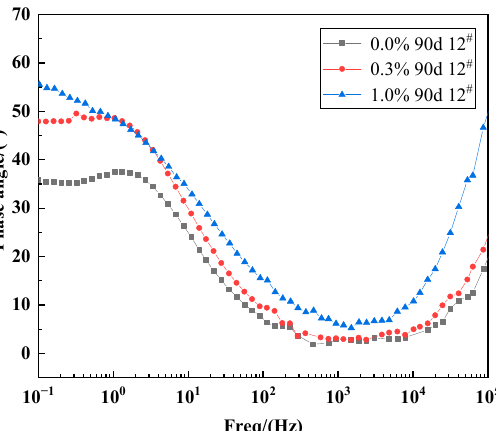
Figure 14. Curves of phase angle versus frequency for X70 steel at position 12 # in a corrosive soil environment with different sodium chloride content at 90 days.